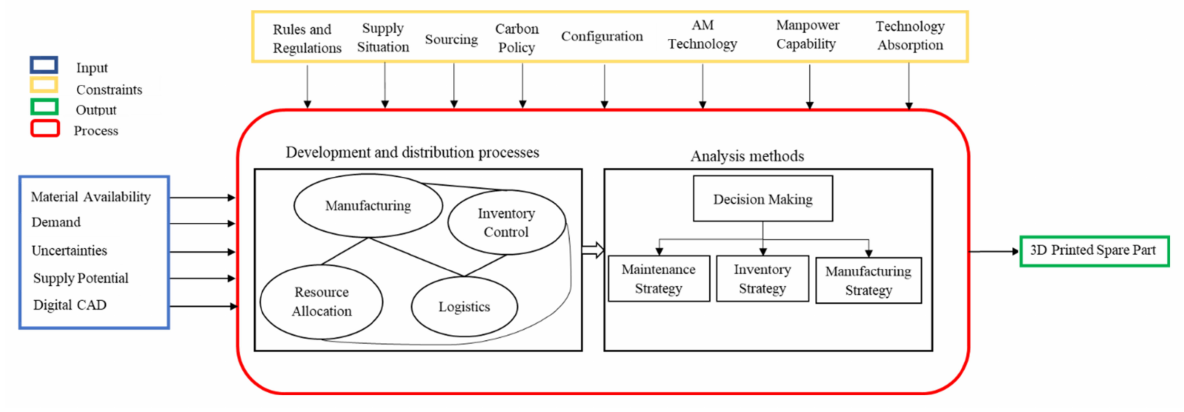
Figure 2. Supply chain process adopting additive manufacturing in spare parts